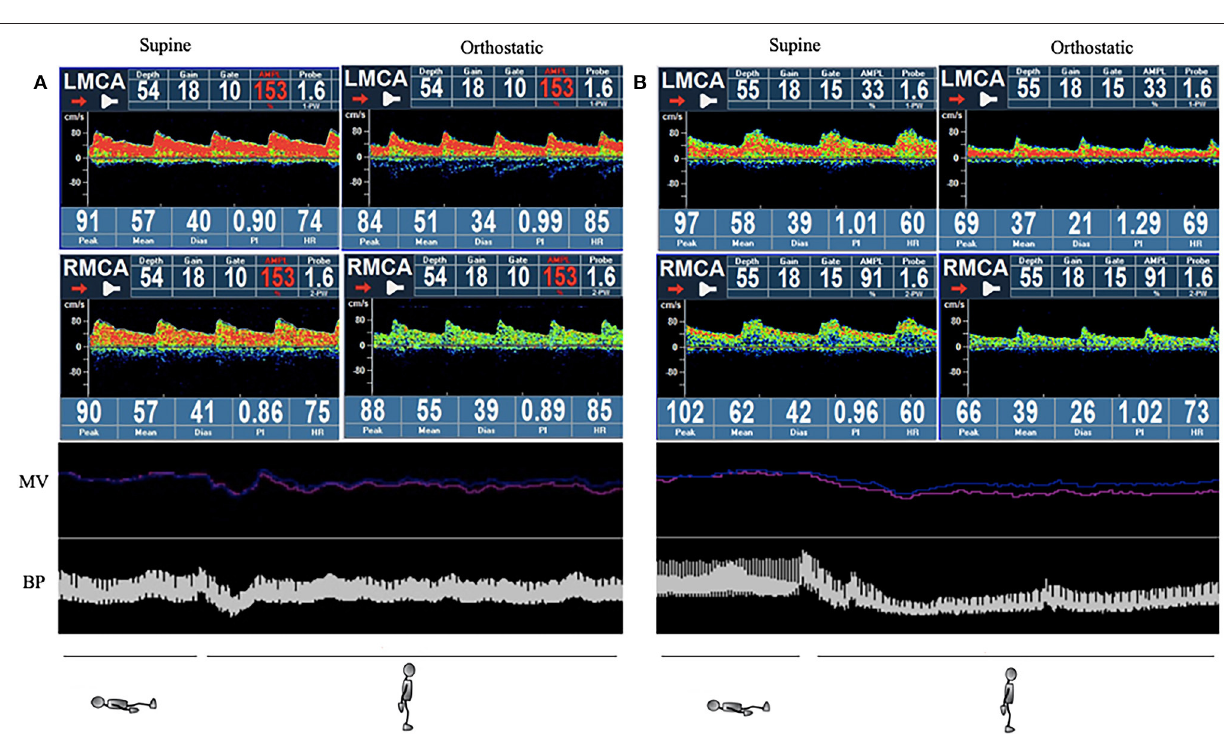
FIGURE 2 | Example of simultaneous monitoring of non-invasive continuous blood pressure (NIBP) and mean velocity (MV) during the active standing test (AST). The red line indicates left side and the blue indicates right side in the MV section. (A) Healthy control: normal blood pressure (BP) drops and recovers quicky to normal levels without MV change. (B) Symptomatic orthostatic hypotension (OH) group: BP and MV drop considerably, and recovery is impaired. NIBP, non-invasive continuous blood pressure; MV, mean velocity; BP, blood pressure; OH, orthostatic